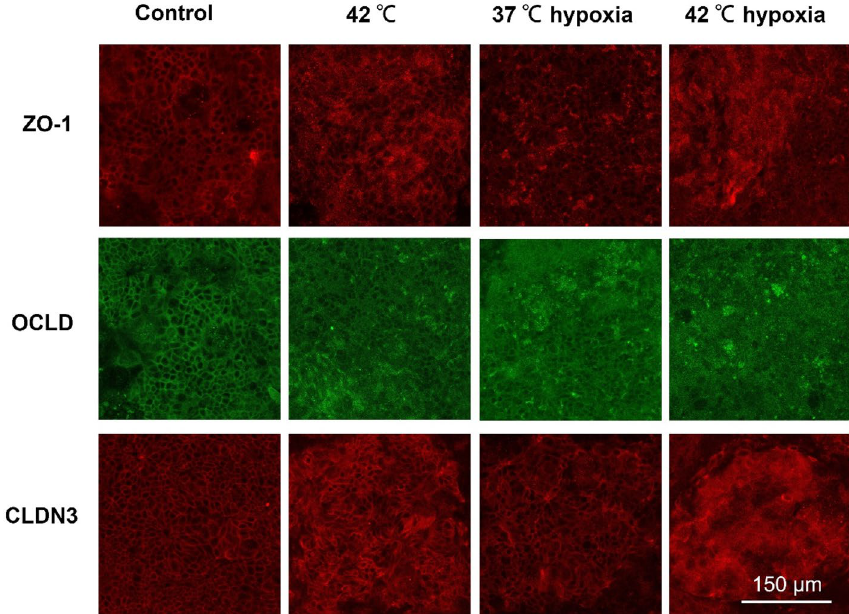
Figure 5. Effects of hypoxia and/or heat treatment on TJ localization in the co-culture model. Red or green color: anti-ZO-1, anti-OCLD or anti-CLDN3 antibody conjugated with Alexa-Fluor fluorescent secondary antibodies. The images were acquired by Leica TCS SP8 microscope with HCX IRAPO L 25 × /0.95 objective lens at 1.6 × digital magnification, pinhole: 1.5 AU. OCLD occludin; CLDN3 claudin-3.